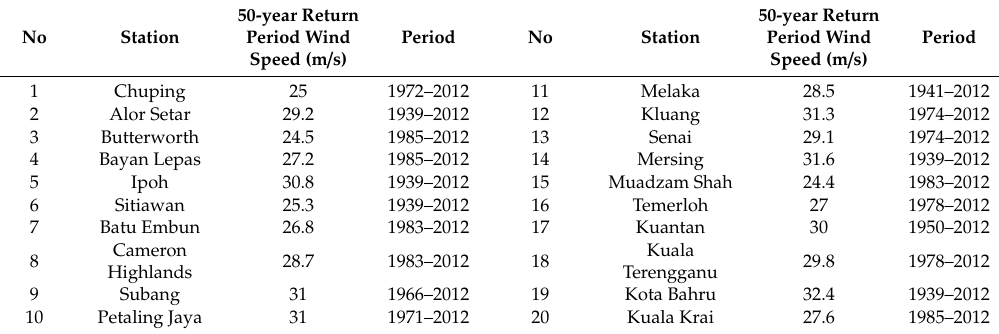
Table 2. The 50-year return period basic wind speed in Peninsular Malaysia.